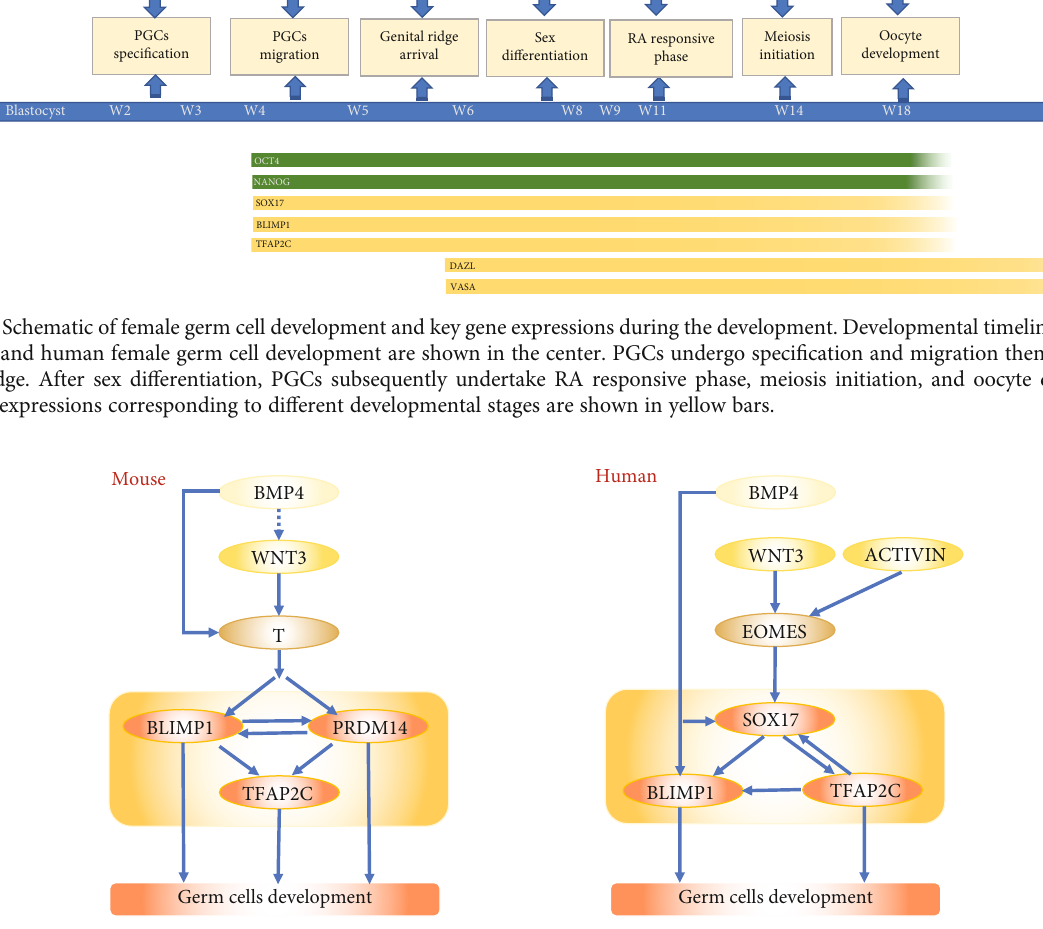
Figure 2: Transcriptional regulatory network models for mouse and human PGCs speci fi cation. Full and dashed arrows indicate direct and indirect regulations,